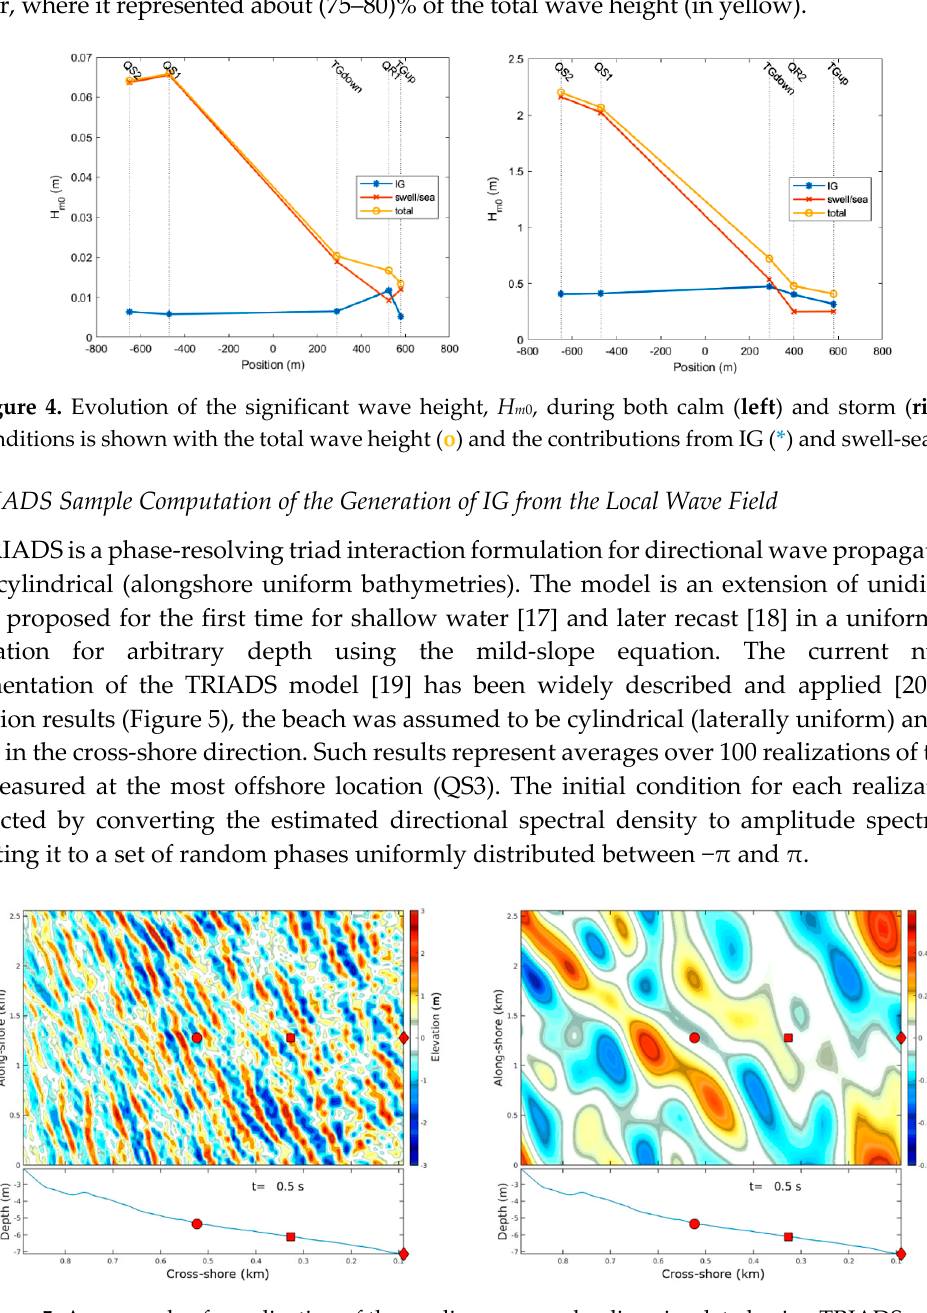
Figure 5. An example of a realization of the nonlinear wave shoaling simulated using TRIADS on the beach fronting the Misa river mouth, showing the sea and swell wave field ( left panel ) associated with the IG field ( right panel